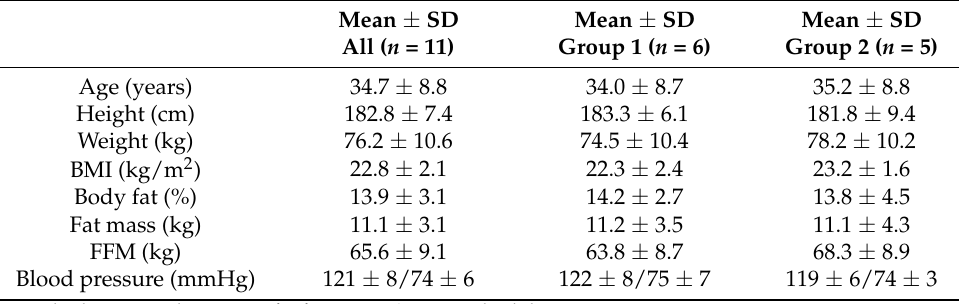
Table 2. Characteristics of the participants included in the acute pilot trial.